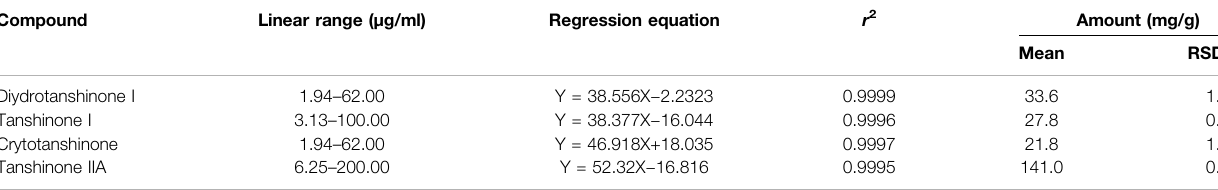
TABLE 1 | Linear range, regression equation, coef fi cient of determination (r 2 ) and amounts of marker compounds in TAN. Compound Linear range (µg/ml) Regression equation